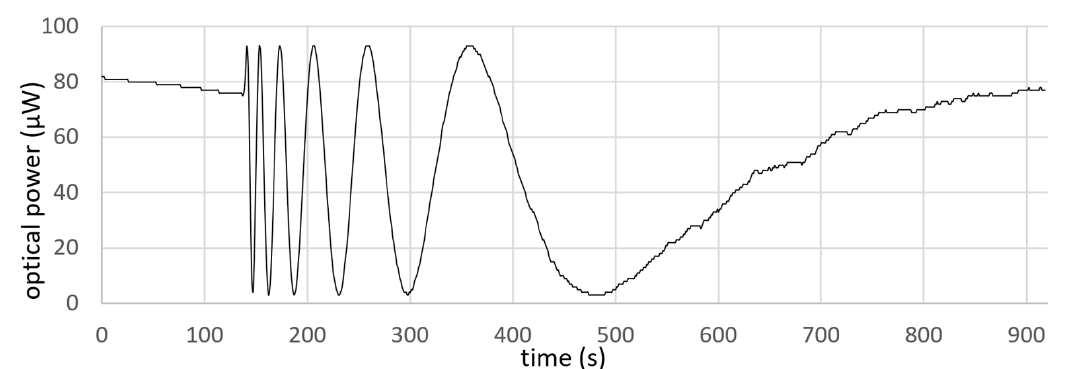
Figure 5. The intensity of the optical signal detected by the photodiode (measurement 379) using a basic connection with a circulator and an optical route with a length of 1 km, according to Figure 4.